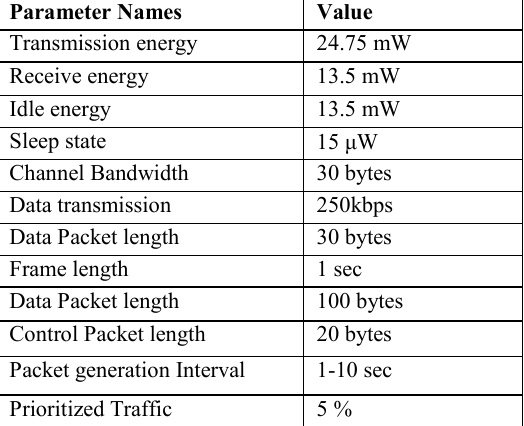
Table I. Simulation Parameter Used For The